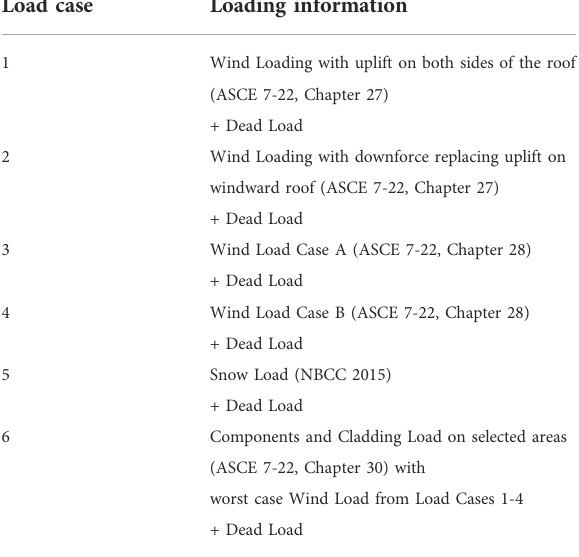
TABLE 3 Load cases applied to the fi nite element model. Load